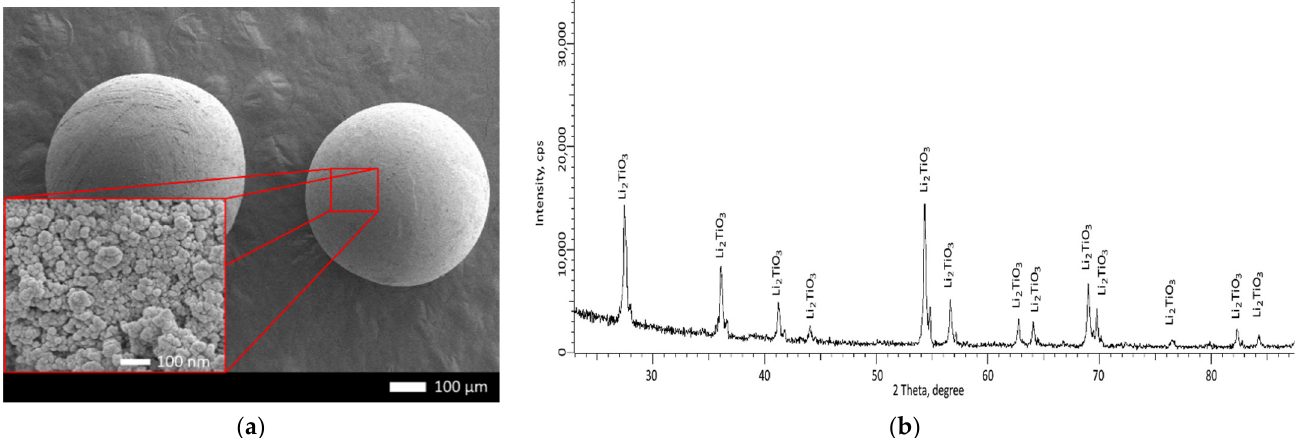
Figure 1. ( a ) SEM—image of the studied ceramics; ( b ) X-ray diffraction pattern of the studied ce-